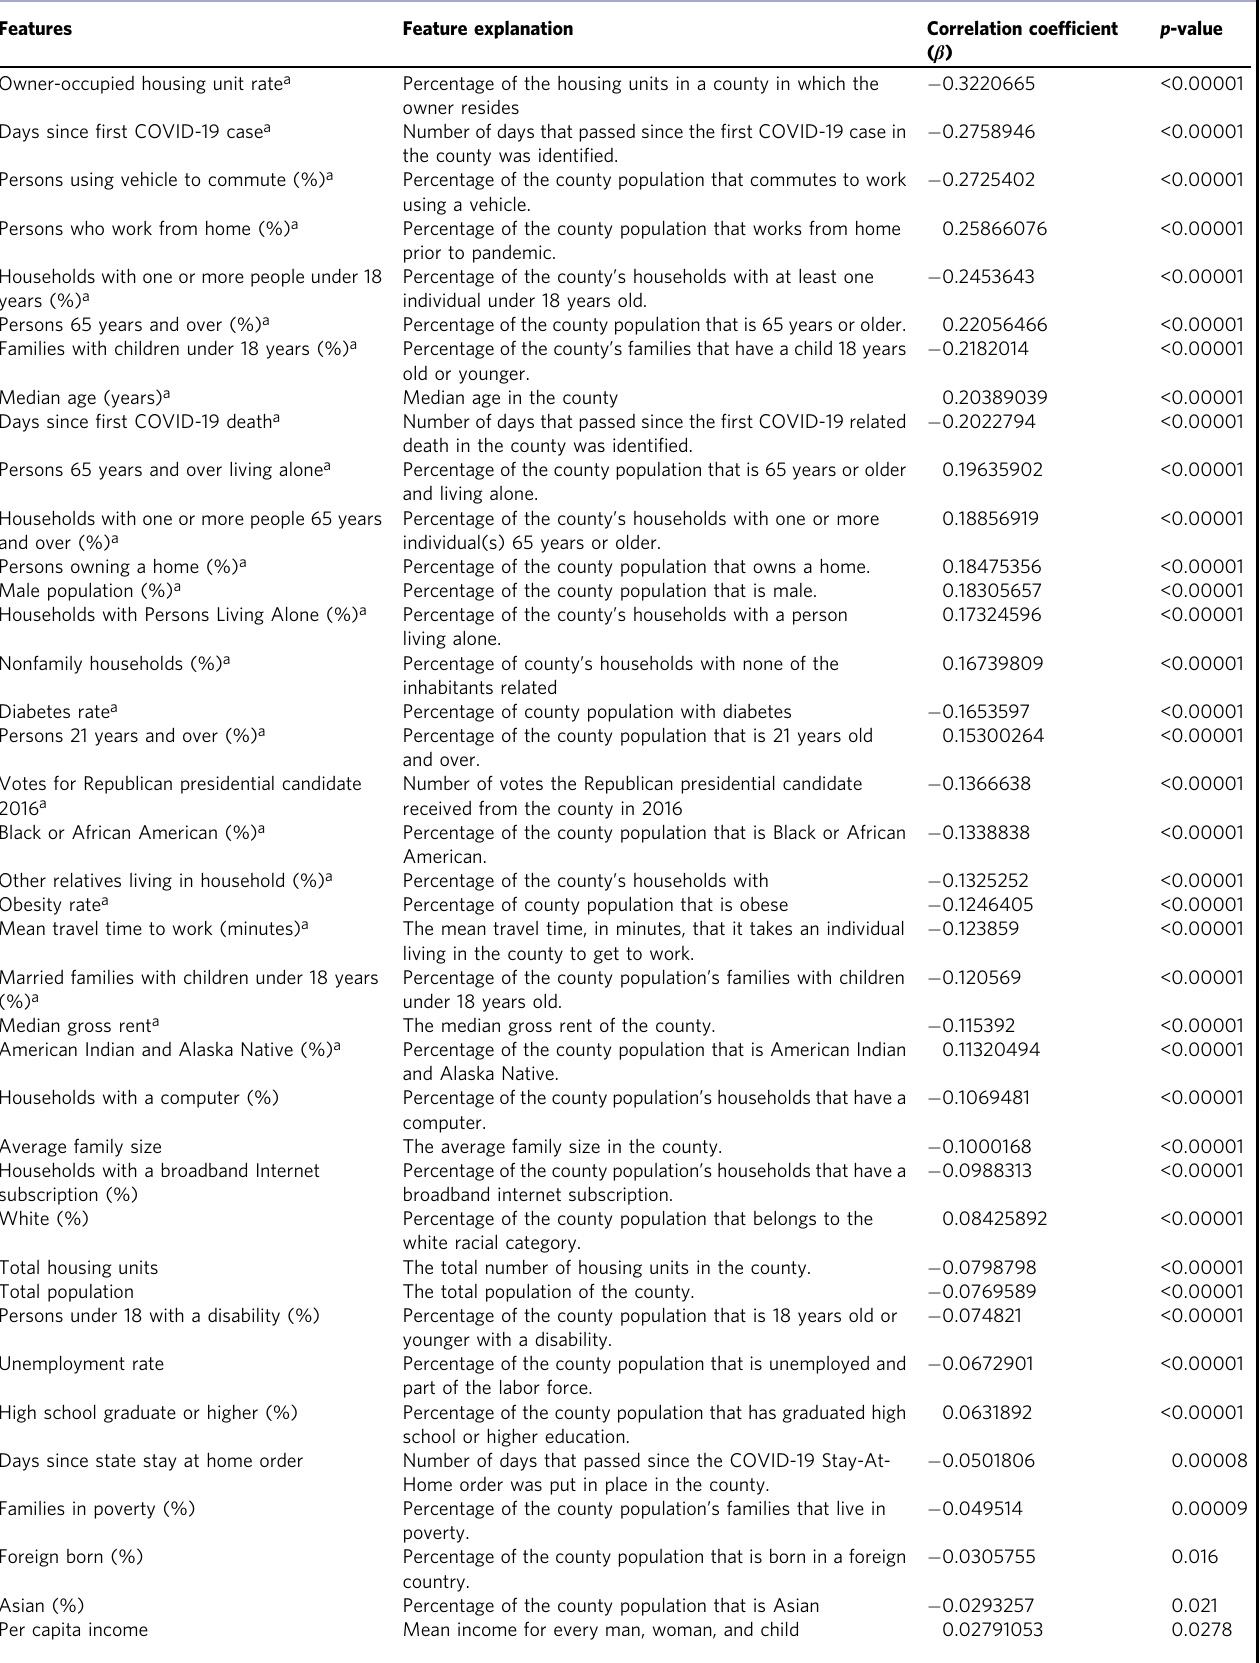
Table 1 Social distancing adherence (SoDA) model